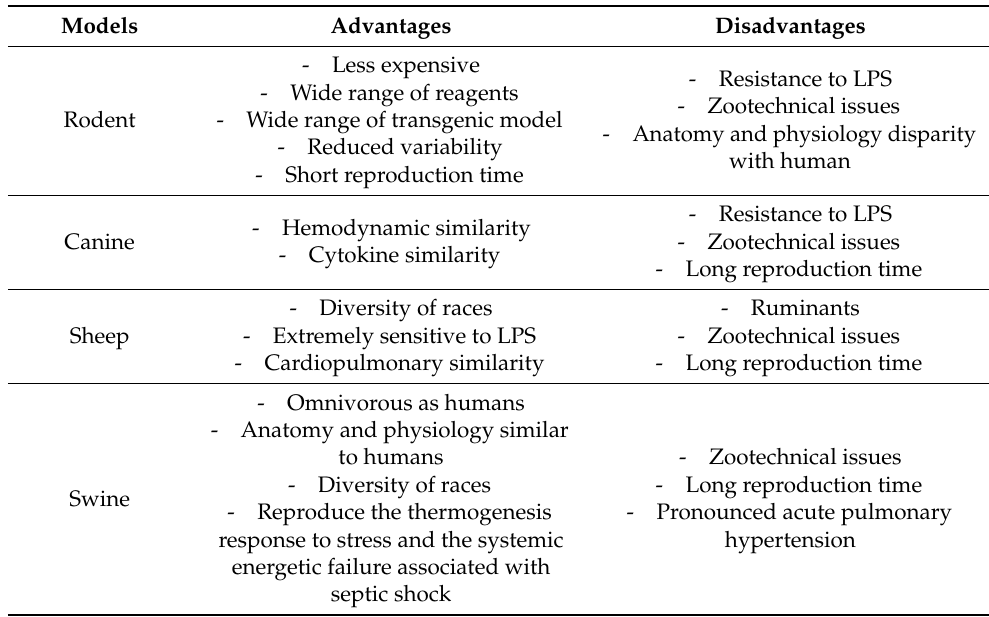
Table 2. Summary of advantages and disadvantages of induced large mammal models adapted from Guillon et al., 2019